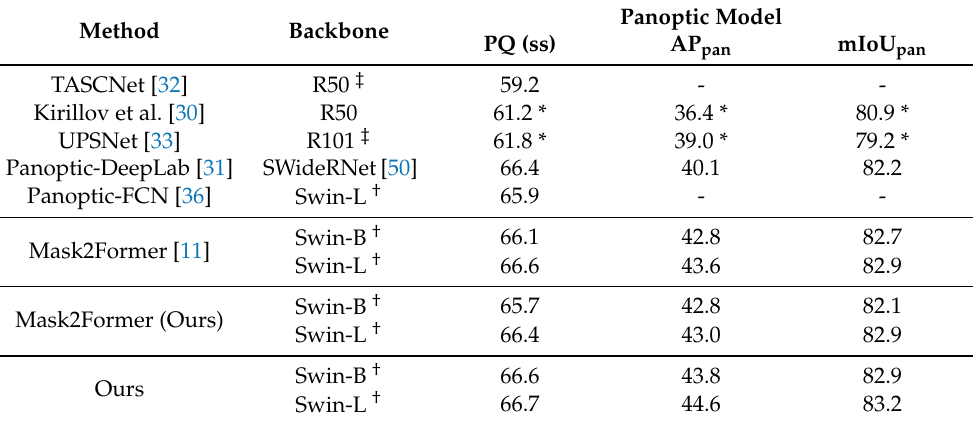
Table 7. Performance comparison of panoptic segmentation on the Cityscapes validation dataset. Single-scale (ss) inference is adopted by default. Multi-scale results are marked with *. †: backbone pretrained on ImageNet-22K. ‡: backbone pretrained on ImageNet-1K and